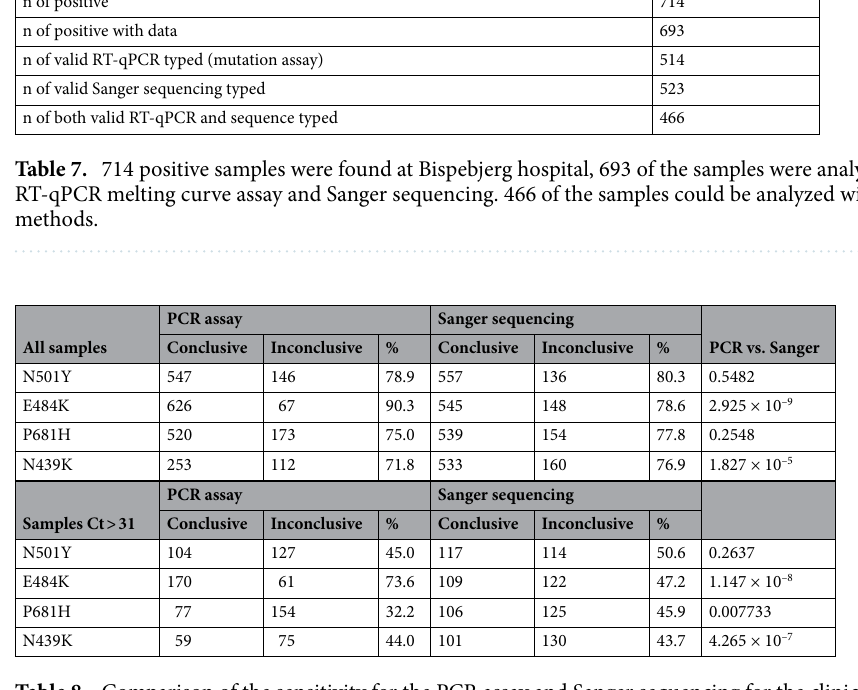
Table 8. Comparison of the sensitivity for the PCR assay and Sanger sequencing for the clinical validation cohort. The samples are divided into two groups: conclusive and inconclusive. Conclusive is when a result was available of the analysis and inconclusive was when a result was not available. The analysis is made for all the samples and the samples with a low amount of viral SARS-CoV-2 RNA (Ct > 31).